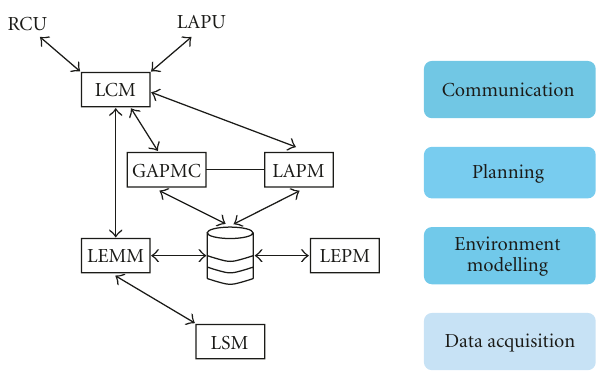
Figure 2: Components of a local area processing unit